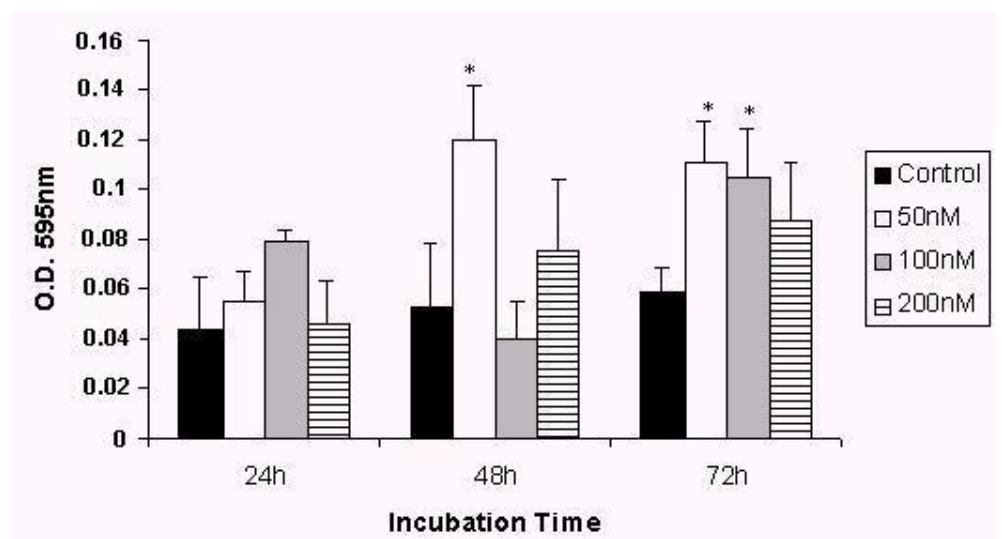
Figure 1. Myoblast viability in absence (control) and presence of ALT-C at different concentrations 24, 48 and 72 hours after incubation, performed in a non-coated plastic plate (*p ≤ 0.05; ANOVA/Dunett).